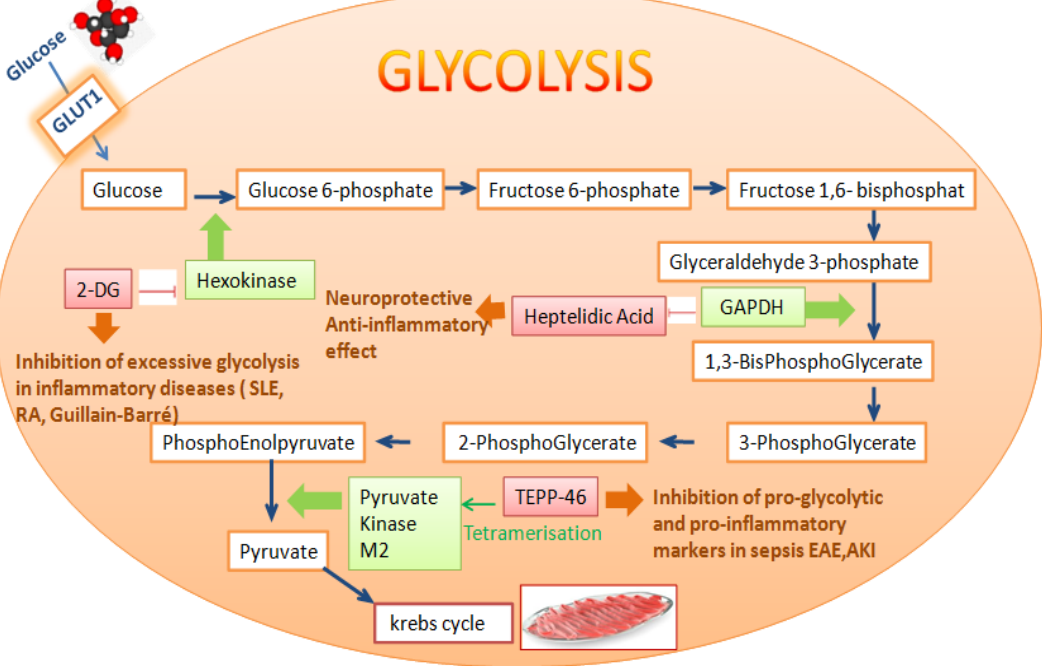
Figure 1. Targeting enzymes of glycolysis as an anti-inflammatory strategy. Glut-1, glucose transporter-1; 2-DG, 2-deoxyglucose; SLE, systemic lupus erythematosus; RA, rheumatoid arthritis; GAPDH, glyceraldehyde 3-phosphate dehydrogenase; EAE, experimental autoimmune encephalomyelitis; AKI, acute kidney injury.